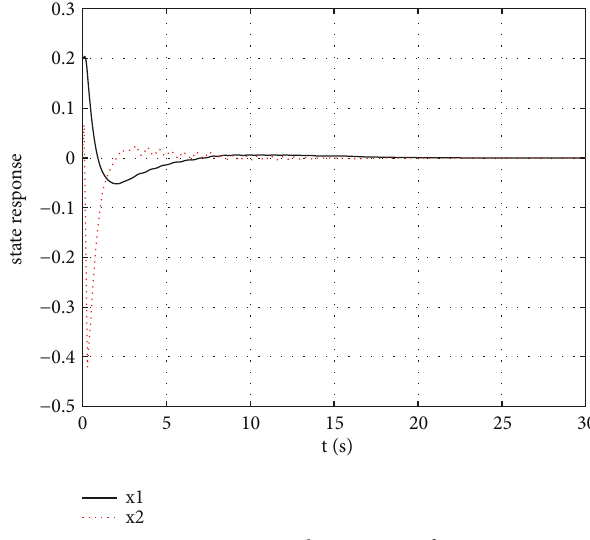
Figure 3: Group 1: the response of state. Figure 4: Group 1: the event-triggered release instants and intervals. Figure 5: Group 2: the mode of time delay.